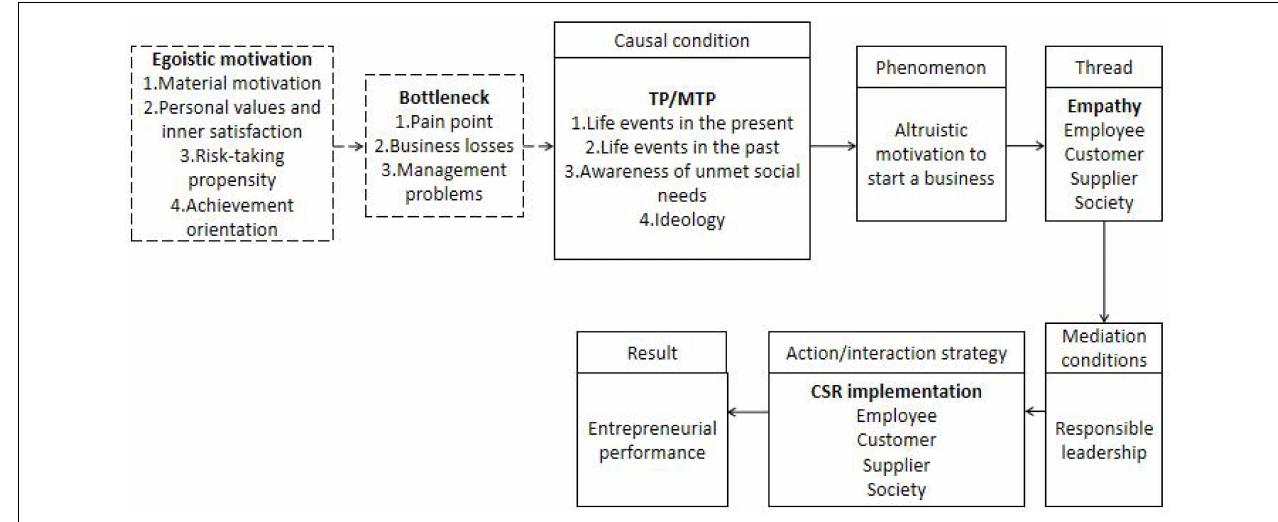
FIGURE 1 | Entrepreneurial motivation evolution canonical model of Chinese